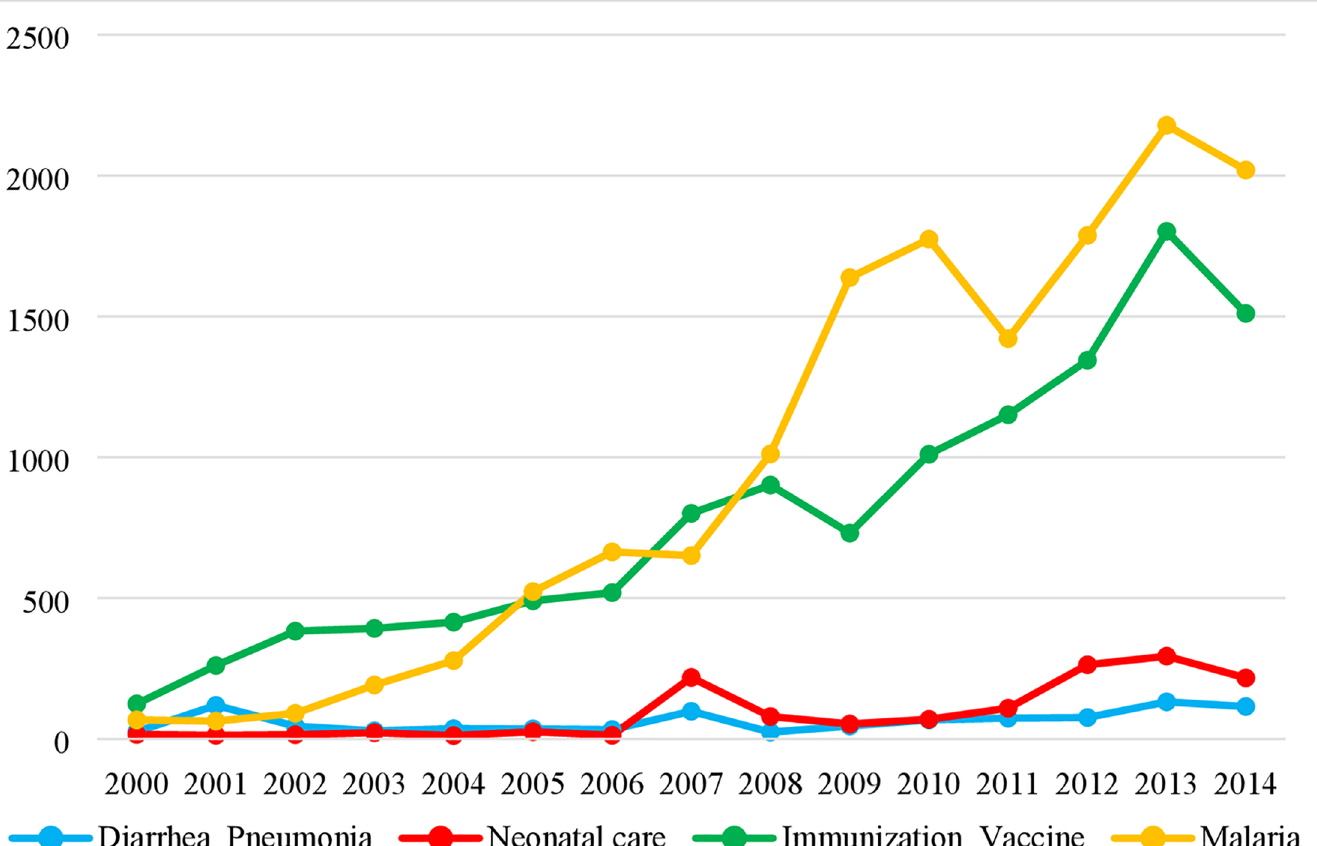
PLOS ONE | https://doi.org/10.1371/journal.pone.0178887 July 11,